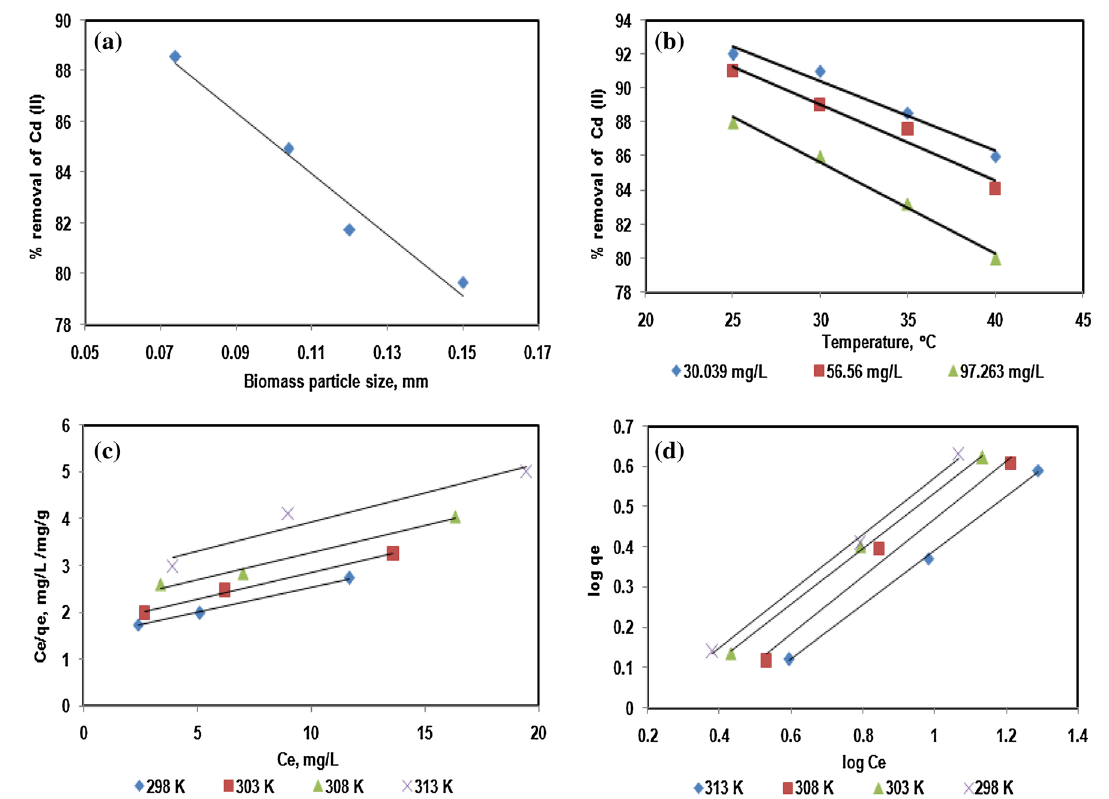
temperatures, biomass weight 20 g L - 1 and at pH 5.5 ( c ), Freundlich plots at various temperatures with biomass weight 20 g L - 1 and at pH 5.5 ( d